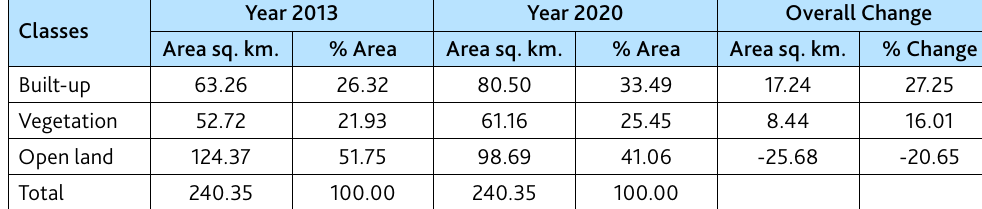
Table 7. Change detection Statistics for Vadodara data set